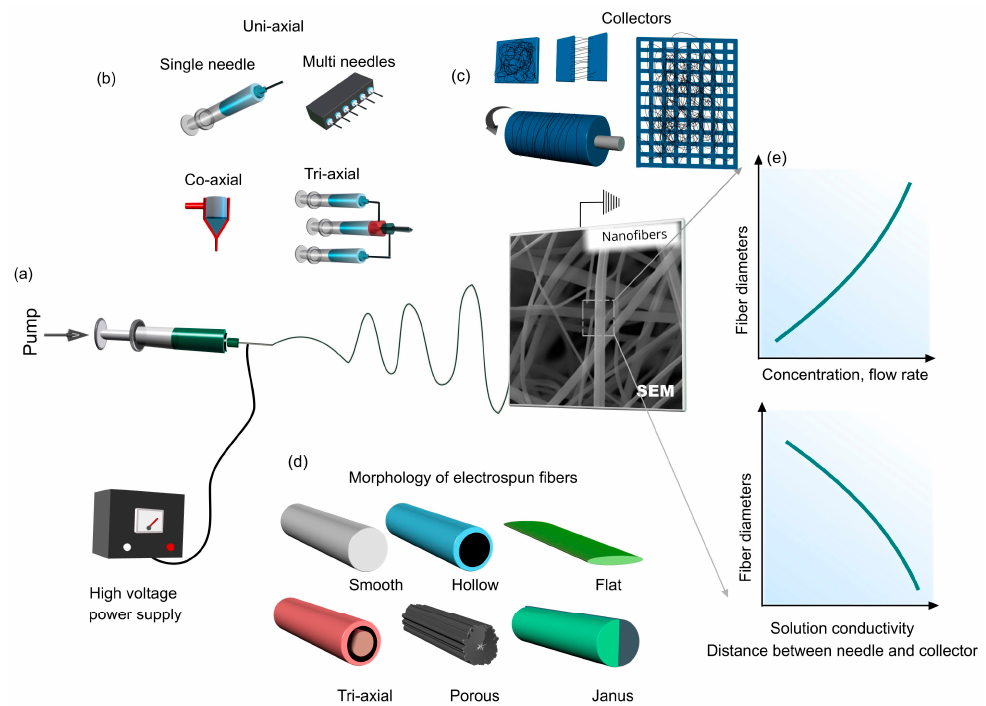
Figure 1. An electrospinning setup with important parameters is shown. ( a ) A cartoon scheme of an electrospinning system with the scanning electron micrograph of electrospun fibers, ( b ) common spinneret systems used in electrospinning, ( c ) collector types, ( d ) the morphology of electrospun fibers, and ( e ) diagrams showing the influence of electrospinning process parameters and solution properties on the electrospun